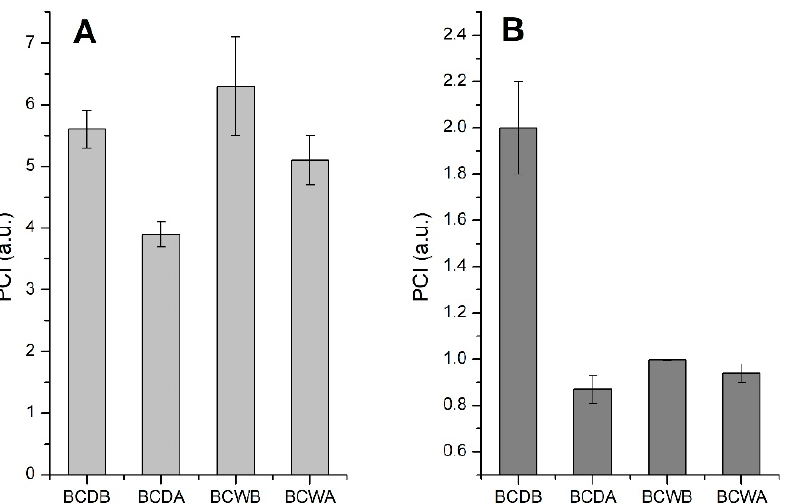
Figure 4. The empirical cumulative frequency distribution for the PCI values obtained by the decay/recovery curves ( A ) and the UPEN algorithm ( B ) at each proton Larmor frequency (points) revealed a normal distribution shape (continuous lines). Hence, the mean and the standard deviation for the PCI values could be obtained by averaging all the values retrieved at each 𝜈 (cid:3013) either by the decay/recovery curves or by the UPEN algorithm. The coefficients of determination reported in the figure were obtained by fitting the points with the normal distribution equation. In the legends, BC stands for biochar, D and W stand for dry − quench and wet − quench, respectively, B and A stand for before and after application to soil.